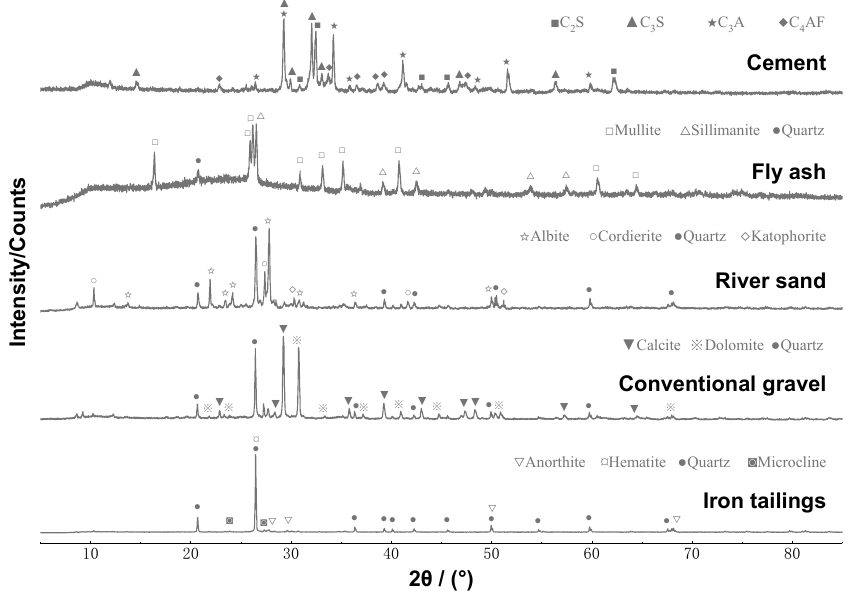
Figure 3. XRD patterns of concrete raw materials.